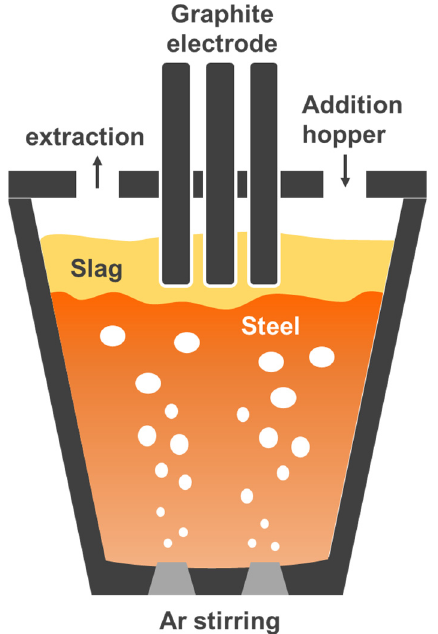
Figure 1. Schematic diagram of the LF (ladle furnace) experiments.